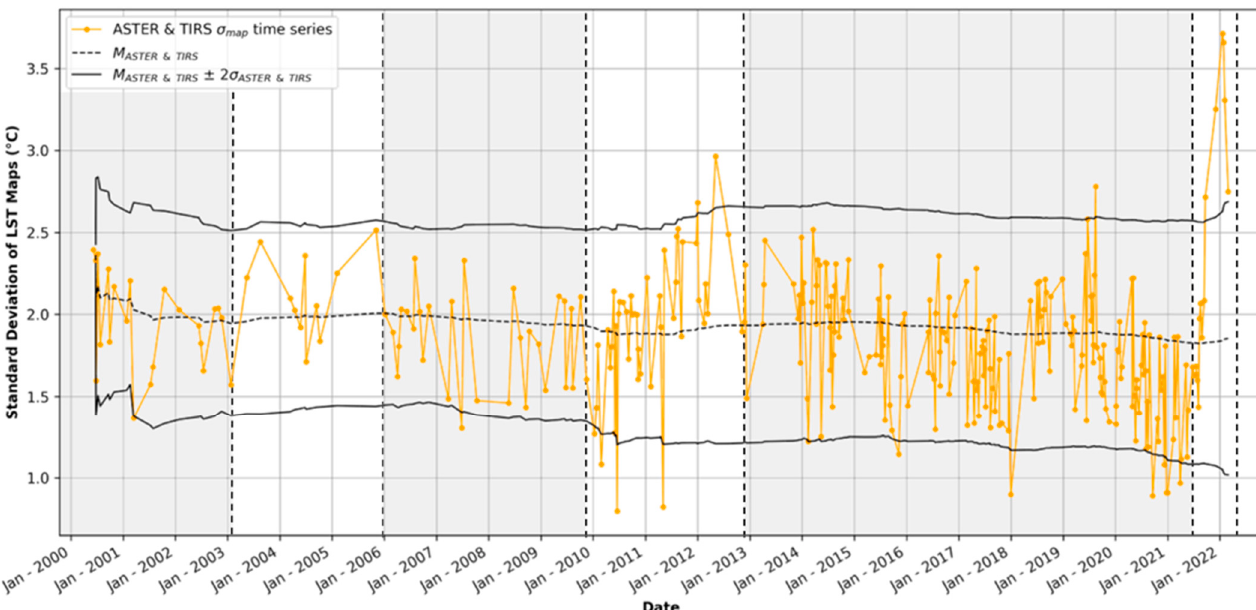
Figure 12. Cumulative analysis: ASTER and TIRS σ map , ±2 σ ASTER&TIRS and M ASTER&TIRS starting from 2000. The three windows highlight the main anomalous events occurred in 2004–2005, 2009–2010 and the last 2021.